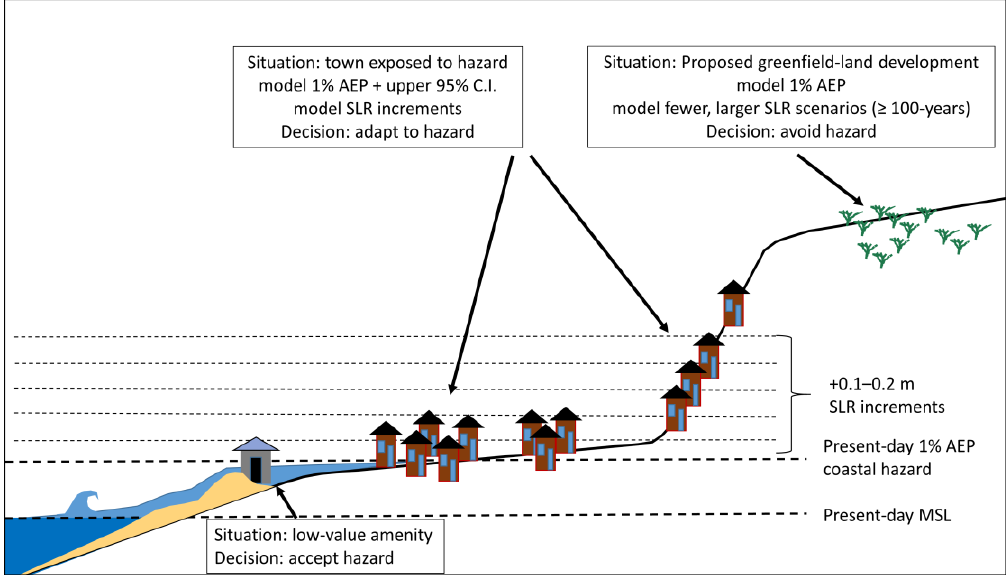
Figure 3. Choice of coastal hazard assessment model scenario based on hazard exposure. The degree of exposure indicates the level of uncertainty the coastal hazard assessment should address, the modeling scenarios required to assist decision making, and the likely complexity of the hazard assessment.